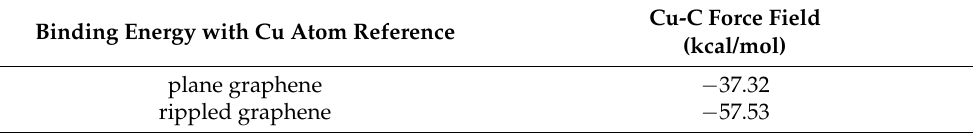
Table 5. Copper binding energies for plane and rippled graphene.